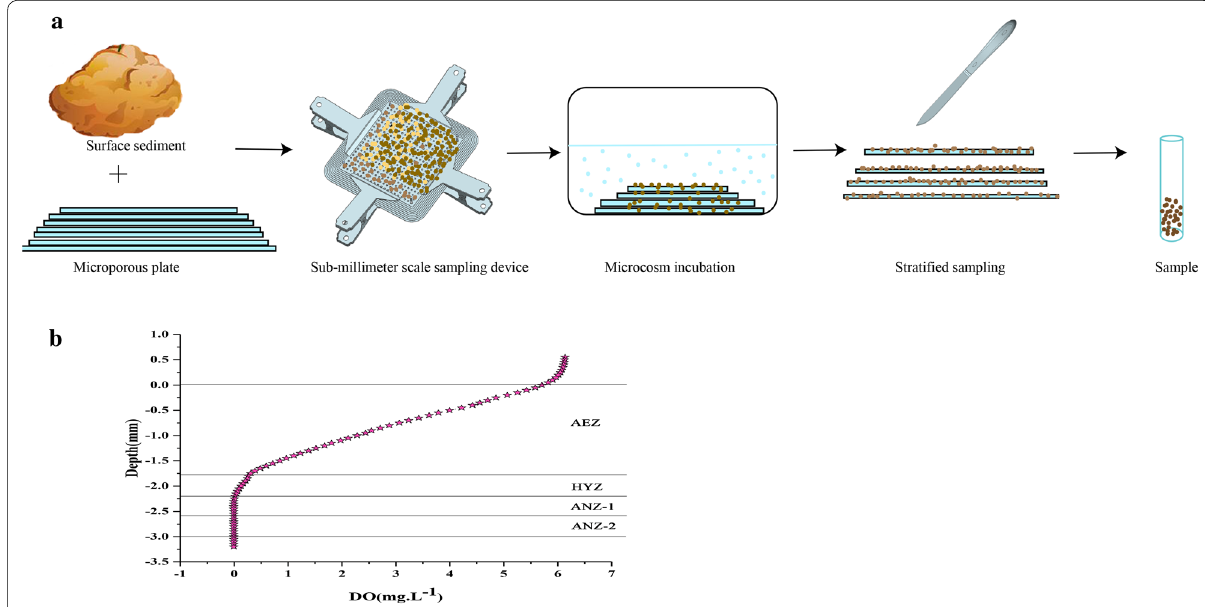
Fig. 1 a Design of the sampling device used in the present study. b Dissolved oxygen profiles at different layers of sediments. AEZ aerobic zone, HYZ hypoxic zone, ANZ-1 up-anoxic zone, ANZ-2 sub-anoxic